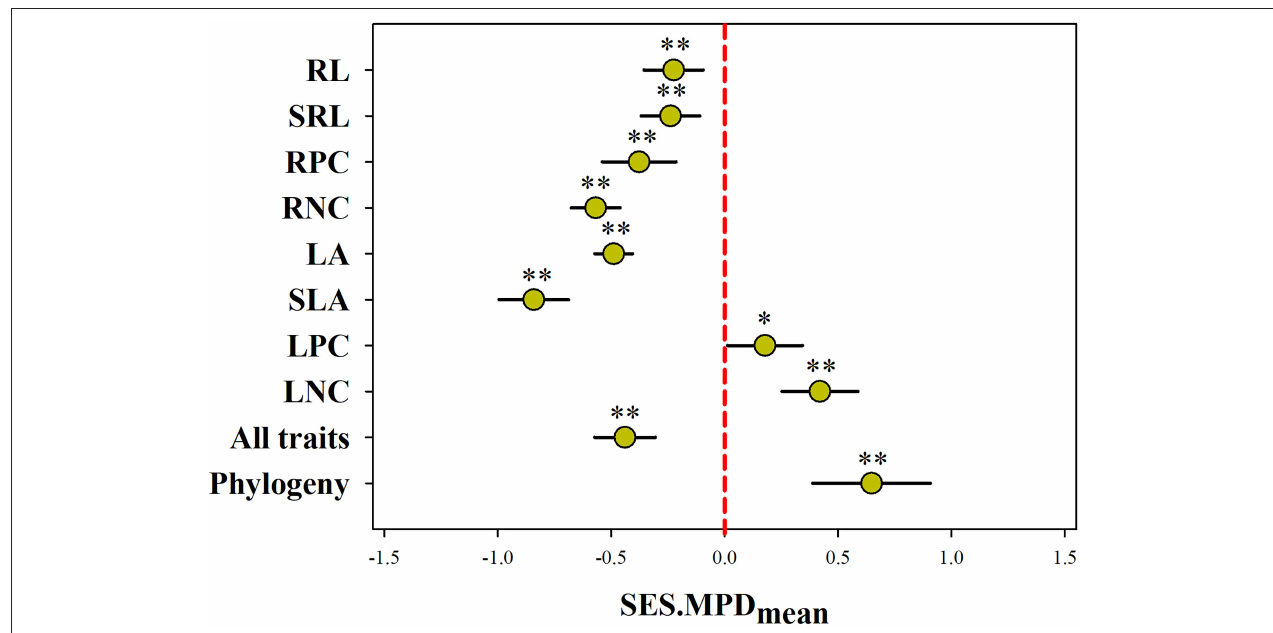
FIGURE 2 | Plant phylogenetic and functional structure assessed using the mean (mean ± 95% confidence) of standardized effect size of mean pairwise distances (SES.MPD) across 183 communities. A negative value indicates phylogenetic and functional convergence, while positive value indicates phylogenetic and functional divergence. SLA, specific leaf area; LA, leaf area; LNC, leaf N concentration; LPC, leaf P concentration; SRL, specific root length; RL, root length; RNC, root N concentration; RPC, root P concentration; all traits, all traits combined; **, p < 0.01; *, p <